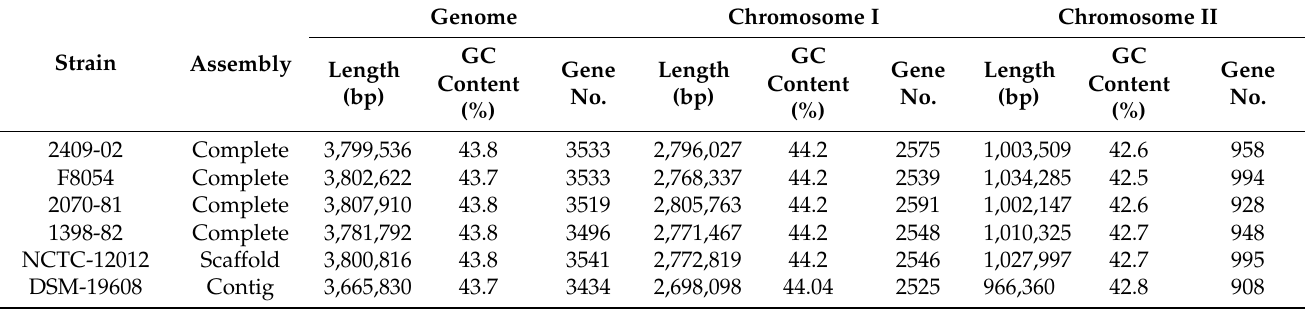
Table 1. General characteristics of the six genomes of V. cincinnatiensis included in this study.